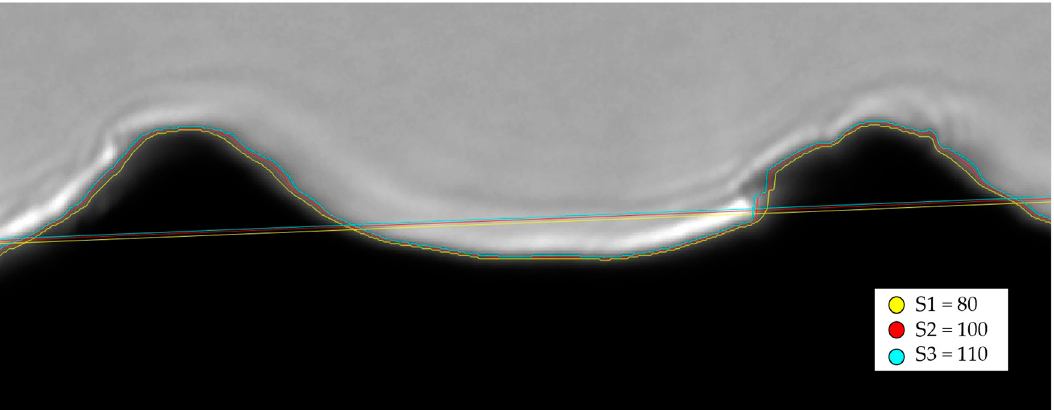
Figure 9. Comparison of different thresholds on the same close-up of the edge: the shape of the profile is maintained and only shifted, therefore R a is not affected. The three thresholds are described in the legend. Image size is 700 × 380 pixels, corresponding to 0.5 × 0.3 mm. The position between the mean lines changes only by 1 pixel. This difference is also coherent with the offset of the profile lines which also differ by 1–2 pixels. If a change in threshold causes a shift in the profile, the estimate of R a does not vary, since R a is a quantity that describes the shape of the profile, not its actual position. The R a values corresponding to the three thresholds (S1, S2, S3) are, respectively: R a = 16.1 µm, R a = 16.6 µm and R a = 16.9 µm.